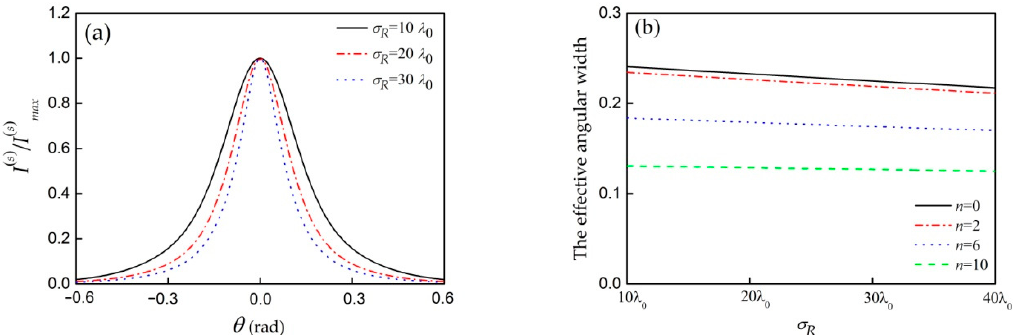
Figure 5. ( a ) Normalized intensity of scattered pulse against scattering angle θ for three different values of effective radius σ R of medium. ( b ) Effective angular width of scattered pulse against effective radius σ R of medium.